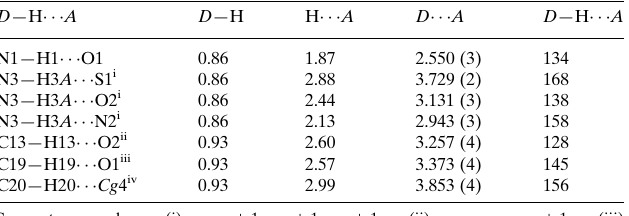
Hydrogen-bond geometry (A˚ , (cid:2)